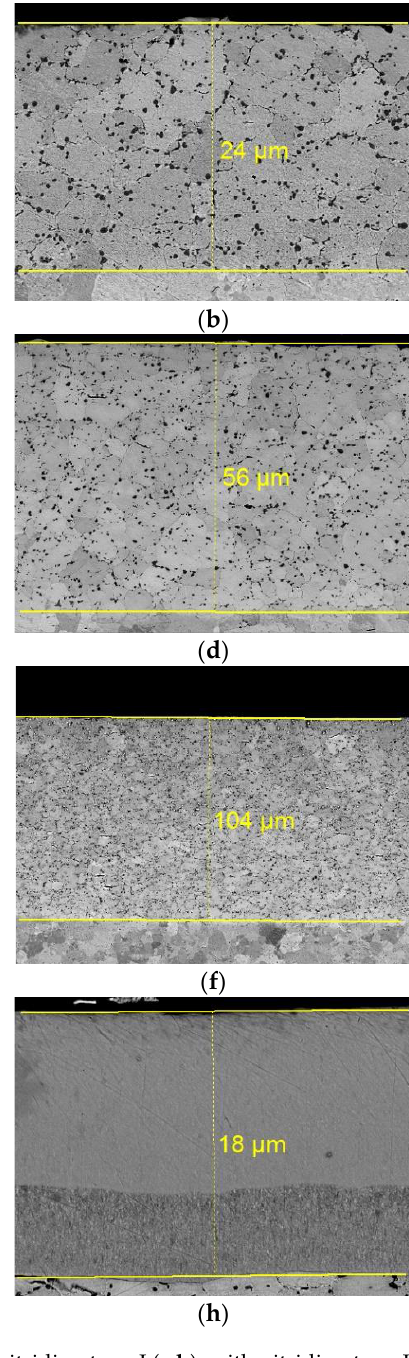
neering Institute. Test rig diagram is shown in Figure 5.